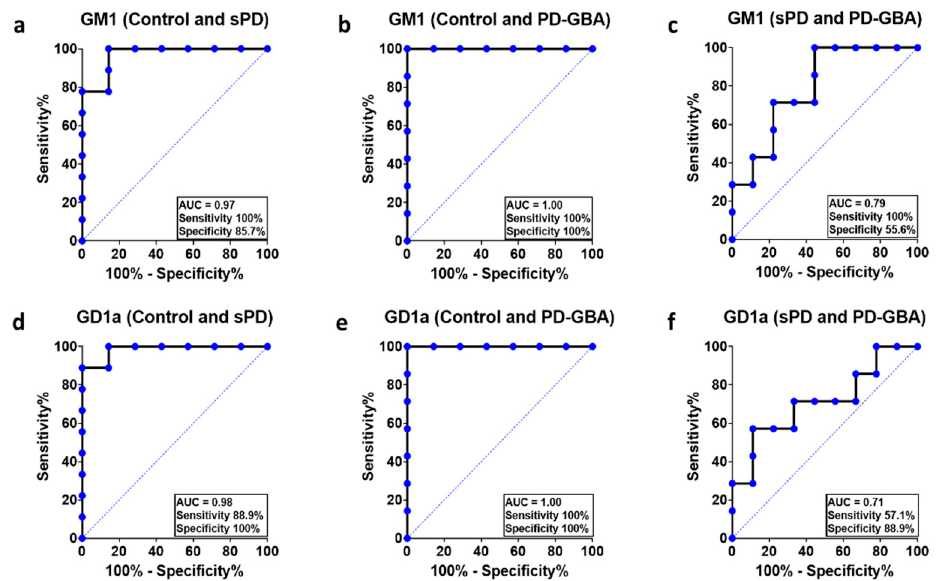
Figure 3. ROC curves of GM1 and GD1a in PBMCs measured using the original analytical method. The ROC curves were used to determine the probability of using GM1 expression in PBMCs to differentiate sPD ( a ) and PD-GBA ( b ) patients from controls; and PD-GBA patients from sPD patients ( c ). The same was analyzed using GD1a expression in PBMCs comparing healthy controls and sPD patients ( d ); healthy controls and PD-GBA patients; ( e ) sPD and PD-GBA patients ( f ). The area under the curve (AUC) and the sensitivity (%) and specificity (%) for cutoff levels are indicated on the plots.